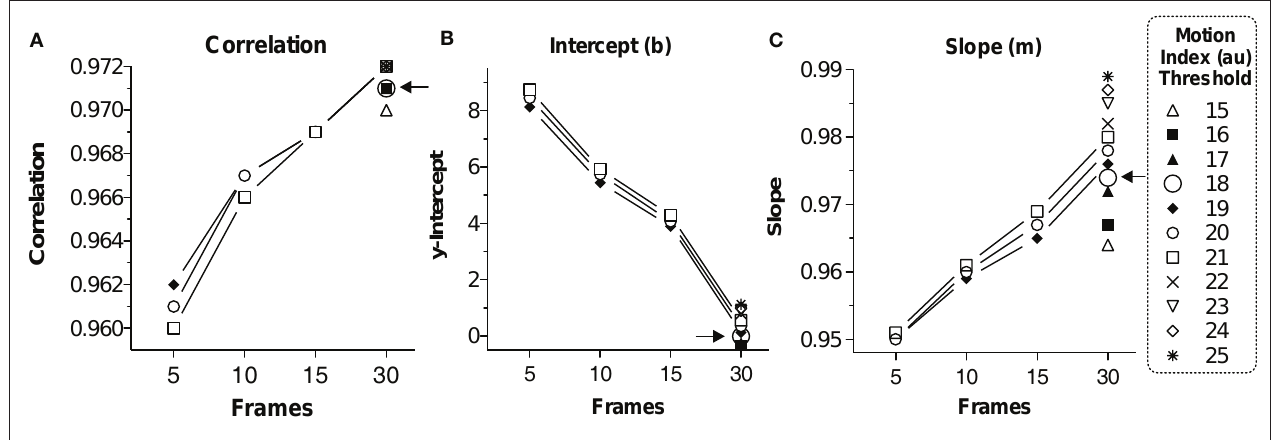
underestimates freezing. Larger number of video frames and lower motion thresholds yielded lower y-intercepts. A threshold of 18 yielded the lowest nonnegative intercept. (C) Slope. The slope term from the linear fit is depicted compared with frames and motion threshold. Larger frame numbers yielded a slope closer to 1. A motion threshold of 18 and number of frames of 30 was chosen for having the best combination of high correlation, intercept close to 0, and slope close to 1. Au, arbitrary